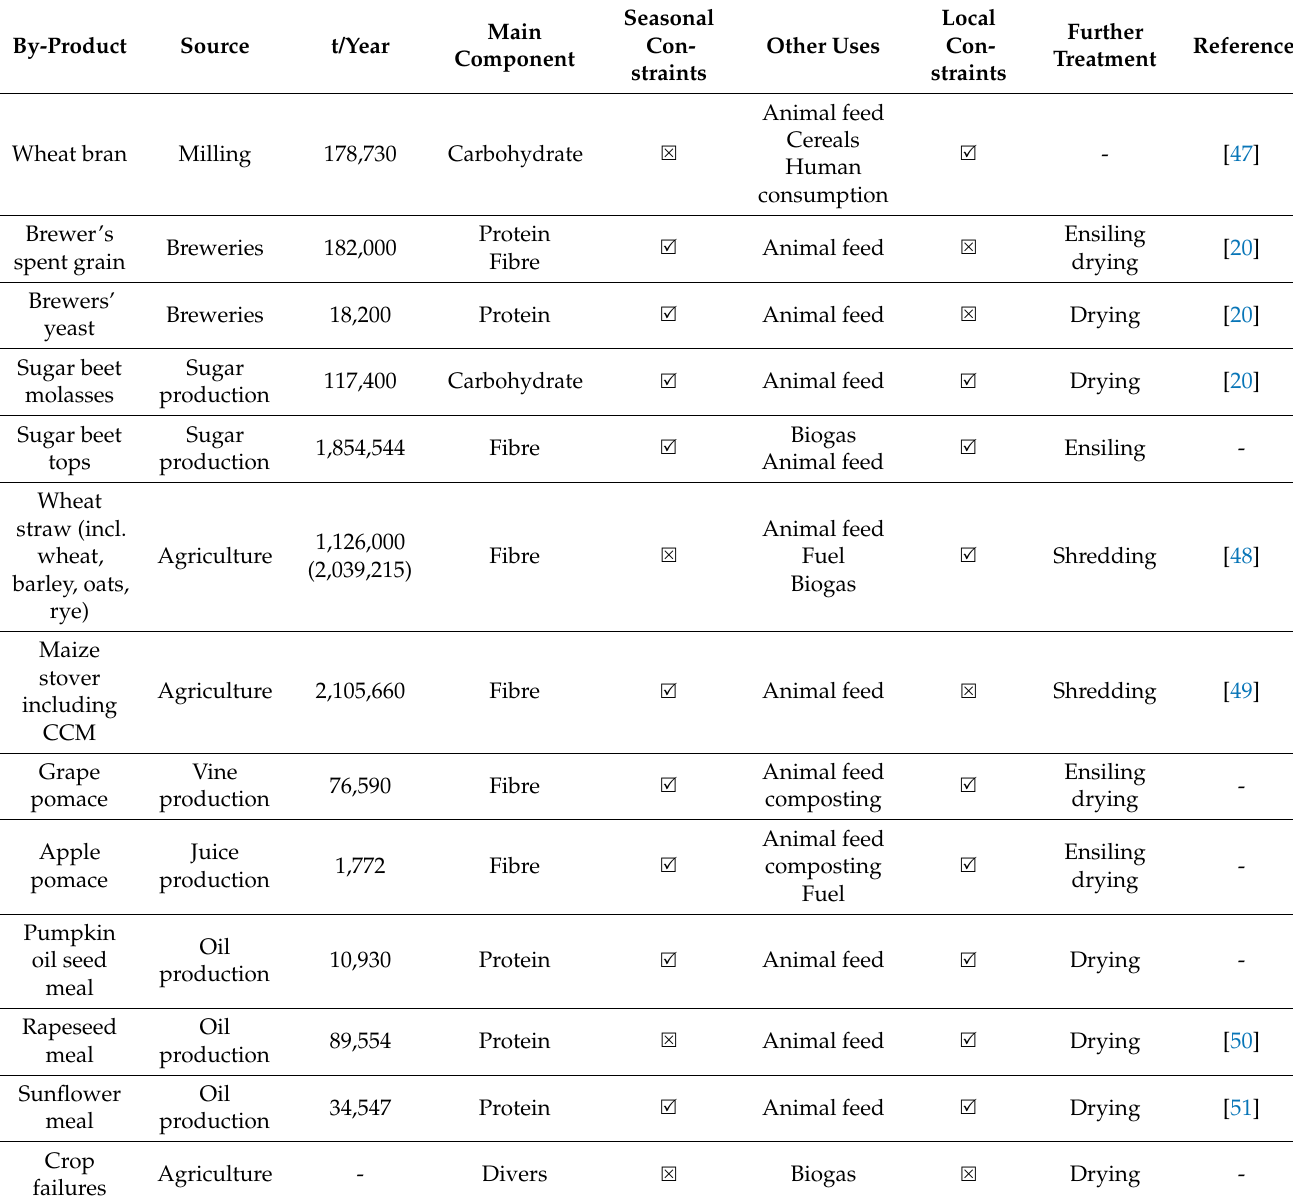
Abbreviation: CCM, corn crop mix.